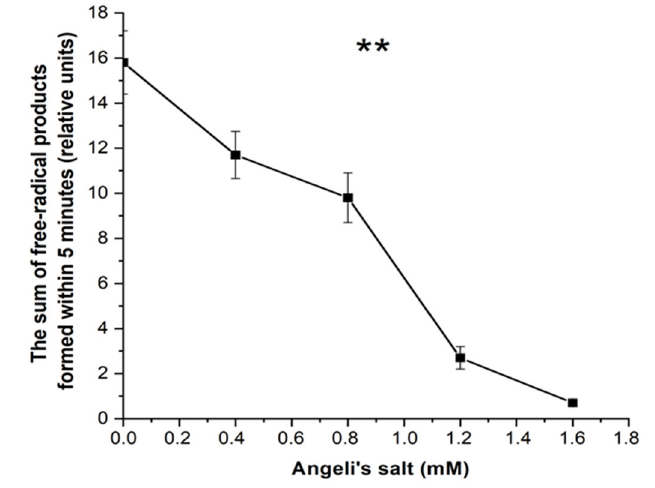
Figure 10. Effect of Angeli’s salt on free radical product formation in the reaction of metHb-H 2 O with t -BOOH, measured with N 1 , N 1 , N 4 , N 4 -tetramethylbenzene-1,4-diamine (TMPD). Reaction mixture: 0.03 mM Hb, 1.42 mM t -BOOH, 0.12 mM TMPD. Results are depicted as the mean with S.E.M. of three independent experiments ( n = 3). One-was ANOVA (** p ≤